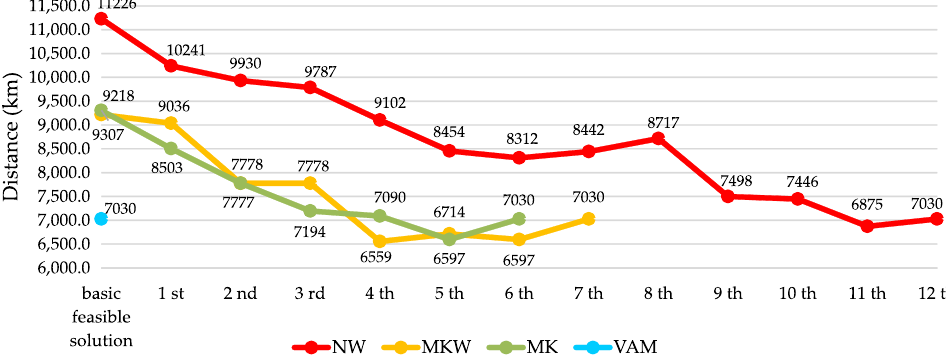
Figure 7. Distance traveled (km) depending on different solutions obtained using potentials